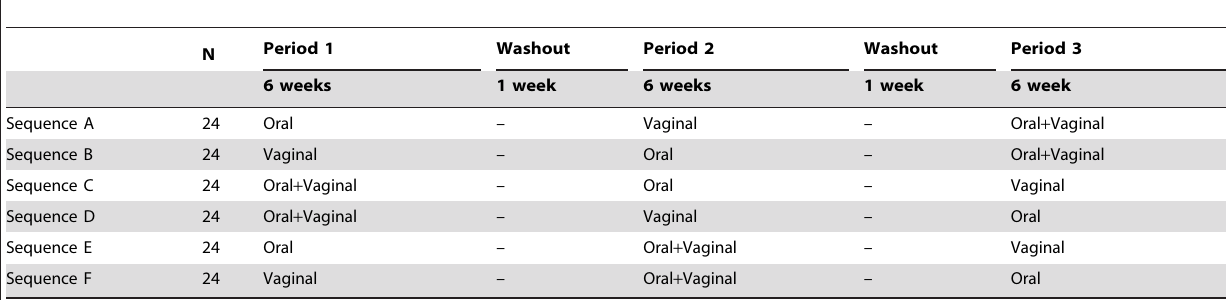
Table 1. MTN-001 Study